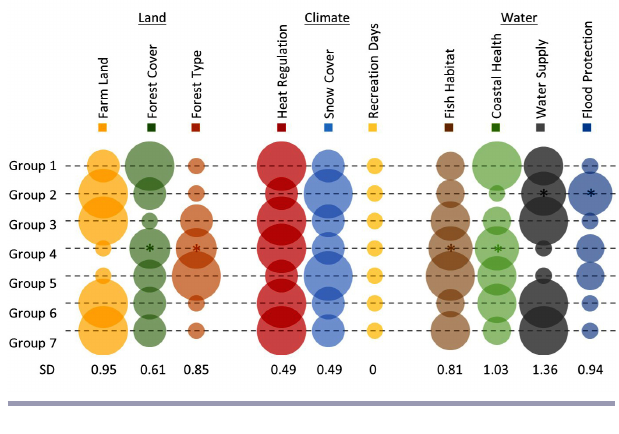
Fig. 2 . Group deliberative rankings of ecosystem services. Size of the circles indicates the importance ranking, with large circles being most important. Asterisks indicate ties. Standard deviations (SD) indicating the degree of disagreement between groups for each ecosystem service are indicated in the bottom margin.